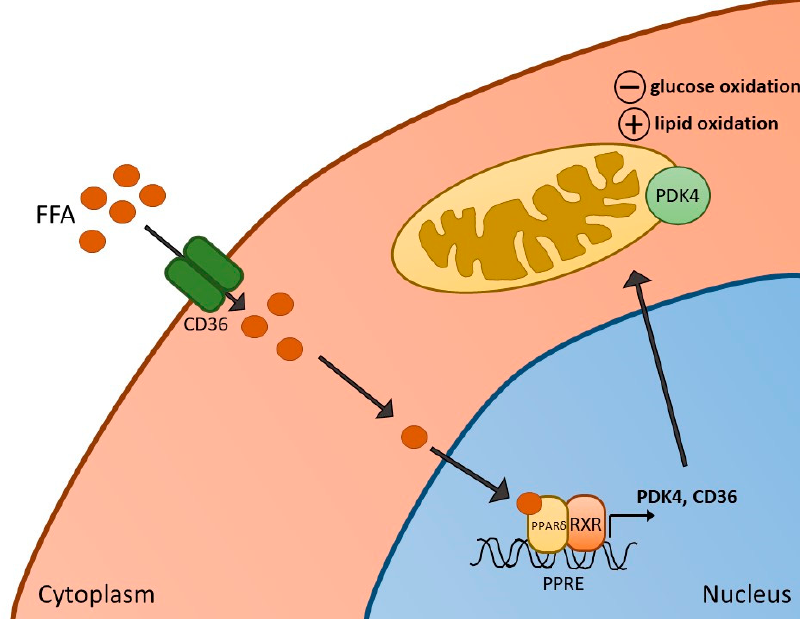
Figure 1. Activation of PPAR δ in skeletal muscle. Increased free fatty acids (FFA) and their metabolites enter skeletal muscle via the FFA transporter CD36, resulting in the formation of a heterodimer of PPAR δ and retinoid X receptor (RXR), and subsequent activation of PPAR δ -dependent genes, such as pyruvate dehydrogenase kinase 4 (PDK4) (and CD36 itself). Activation of PDK4 can result in reduced rates of glucose oxidation as well as increased fatty acid oxidation in mitochondria.